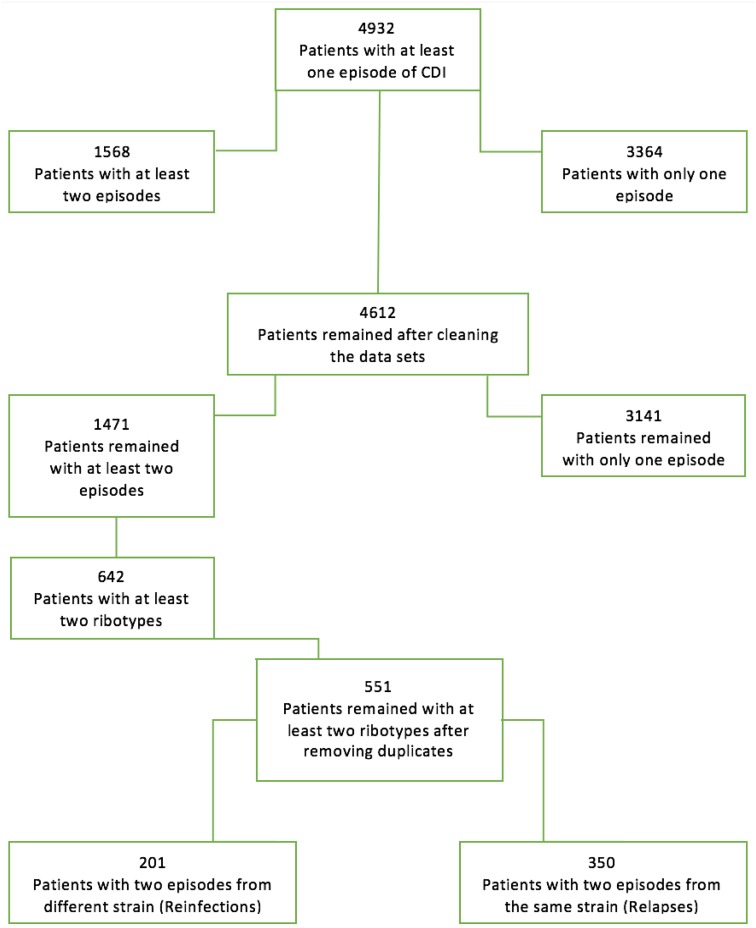
Distribution of episodes of CDI.